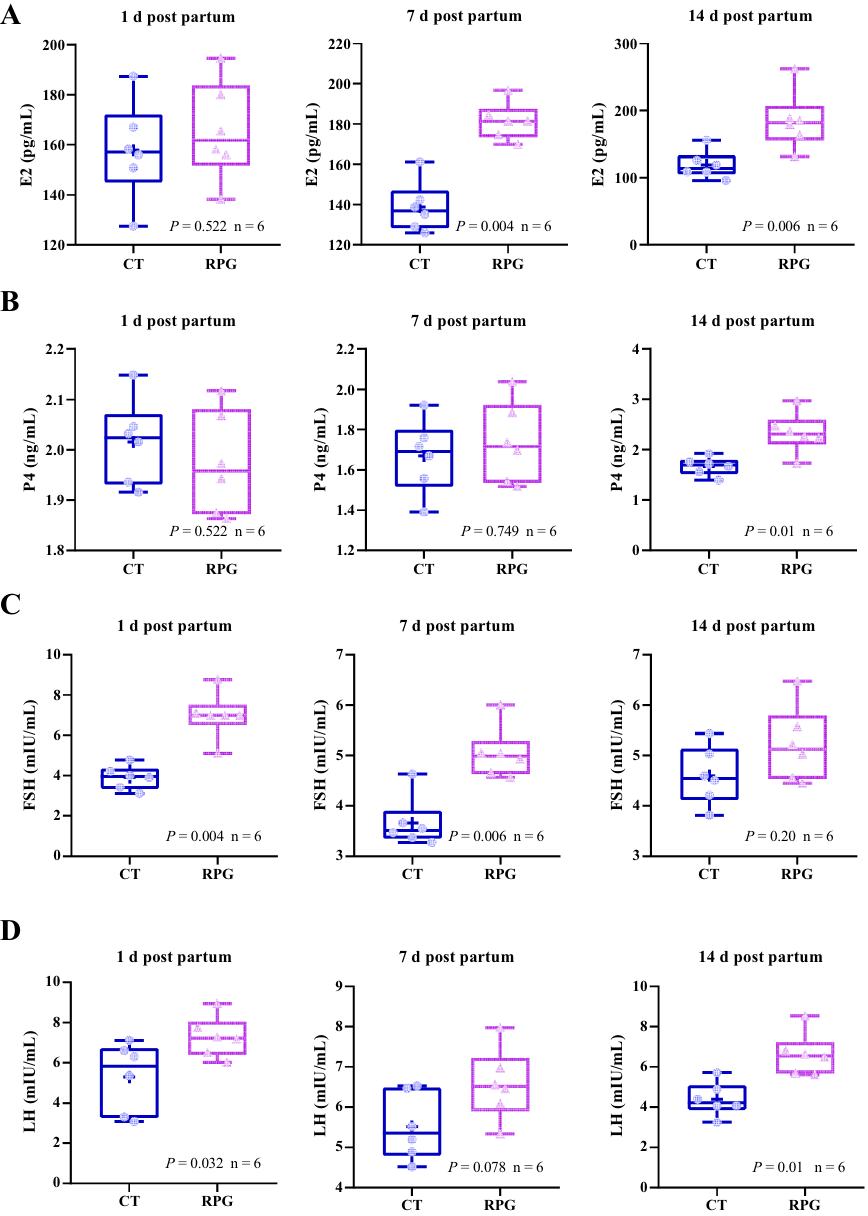
Figure 2. Box and whisker plots of the plasma concentrations of ( A ) E2, ( B ) P4, ( C ) FSH, and ( D ) LH from postpartum dairy cows that show significant ( P < 0.05) or a tendency (0.05 < P < 0.1) between control diet and rumen-protected glucose diet. E2: P Time = 0.562, P Group = 0.000, and P Time×Group = 0.17; P4: P Time = 0.002, P Group = 0.003, and P Time × Group = 0.001; FSH: P Time = 0.003, P Group = 0.000, and P Time × Group = 0.001; LH: P Time = 0.228, P Group = 0.000, and P Time × Group =